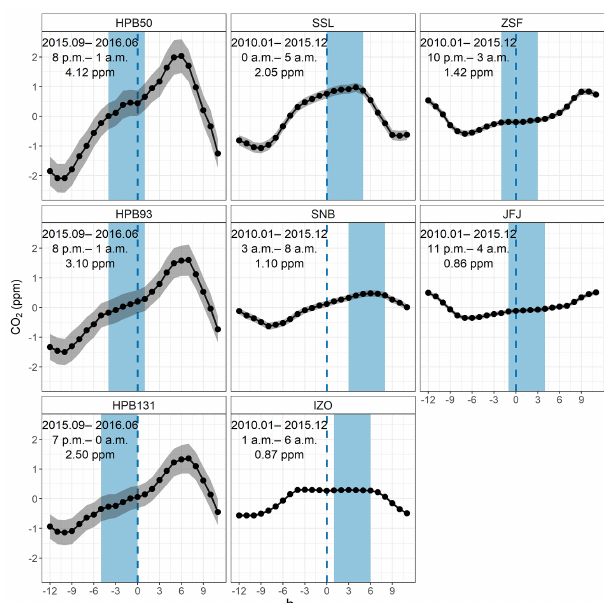
Figure 2. Detrended mean diurnal cycles of validated CO 2 datasets (black) with 95% confidence intervals (gray) from six GAW sta- tions (hours in LT). Measurements at HPB are differentiated by the sampling heights (e.g., HPB50 for 50ma.g.l.). The covered time periods (top text), resulting start time windows (middle text, also in light blue shades), and mean diurnal amplitudes (bottom text) are shown in each subplot.